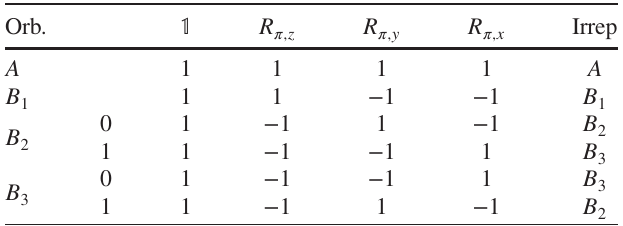
TABLE III. Characters table of the representations of the little for k ¼ X . Each row corresponds to an EBR as group G k identified by the orbital type on sublattice s ¼ 0 . For the cases in which the same EBR gives rise to two one-dimensional irreps of G , the Bloch waves are sublattice polarized. The sublattice k (0 or 1) is indicated in the first column. For the maximal k point X and R , the little group can be decomposed as a sum of lattice translations and the point group D 2 . This property allows us to identify each irrep of G with an irrep of D 2 , indicated in the last k column.